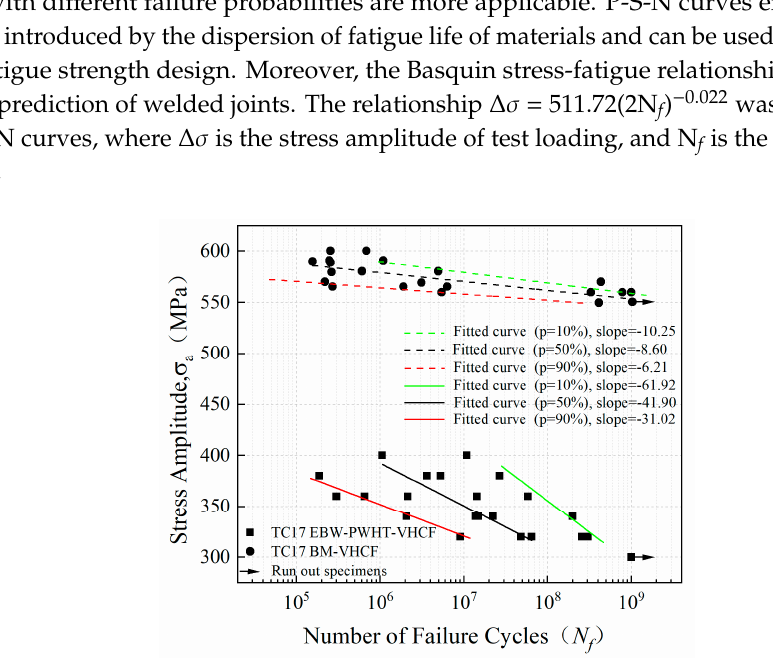
Figure 7. S-N curves of the welded joints of TC17 alloy in very high cycle fatigue Figure 7. S ‐ N curves of the welded joints of TC17 alloy in very high cycle fatigue regime.